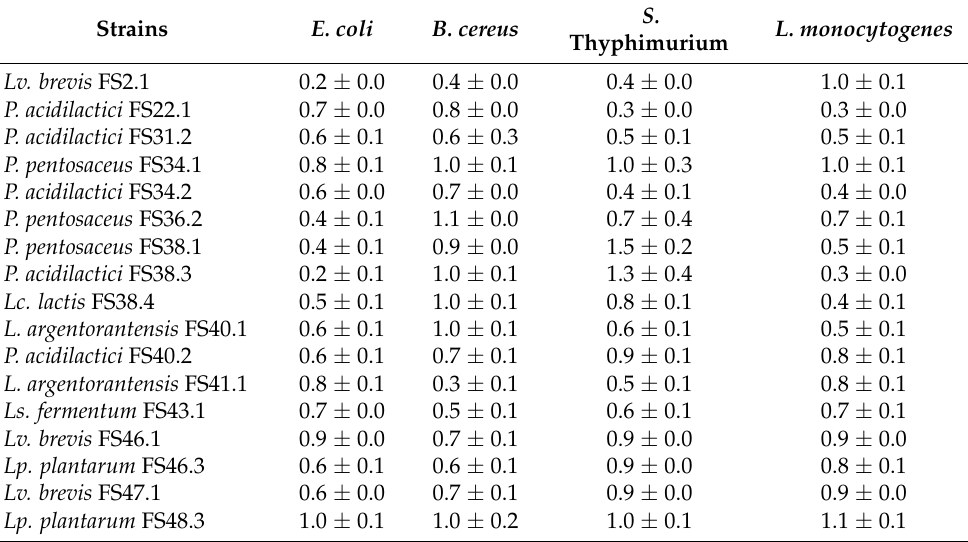
Table 4. Range of clear zone (centimeter) representing antimicrobial activity against some foodborne pathogens of culture broth obtained from XOSs fermentation by XOSs-fermenting LAB. Strains E. coli B. cereus